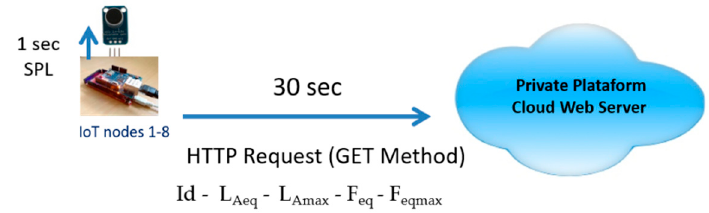
Figure 8. The Hyper Text Transfer Protocol (HTTP) request—GET method.